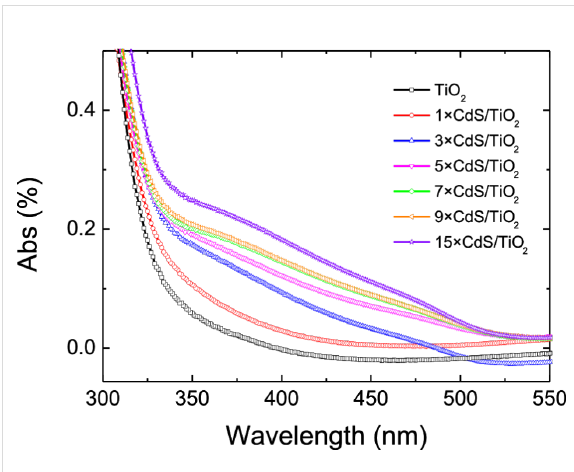
Figure 4: Absorption spectra of the CdS-sensitized titanium dioxide films after different numbers of deposition cycles.